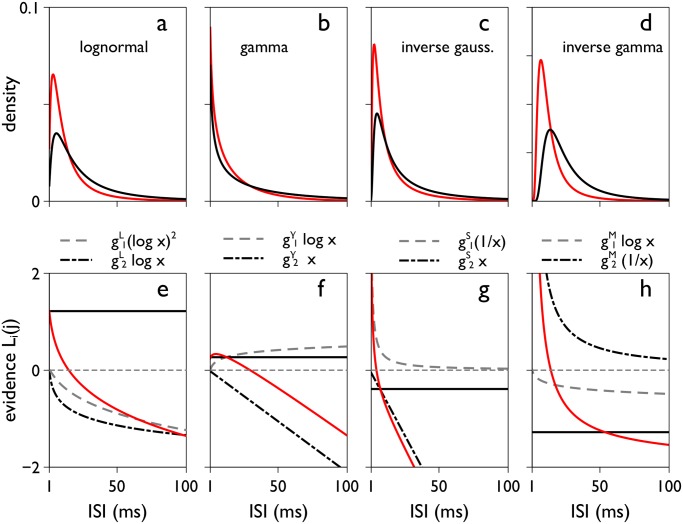
The two-parameter families of pdfs (top) and their ‘evidence contributions’ L
i(j) (bottom).Panels a-d show the lognormal, gamma, inverse Gaussian, and inverse gamma pdfs respectively, for the independent variance parameter set ΩIV (see Methods). The ‘preferred’ and ‘null’ density functions (f
*, f
0) are in red and black respectively. The plots are for ISIs from 1 to 100 ms. For infinitesimal ISIs, the lognormal, inverse Gaussian and inverse gamma tend to zero; for the the gamma the pdf grows up to a bound as the ISI tends to zero. Panels e-f are the corresponding contributions L
i(j) to the accumulated ‘evidence’ y
i(T) (see Eq 9) and the separate components therein (see Table 1). L
i(j) itself is shown in red, the constant term g0D (D = L, γ, S, M) by the solid black line, and non-constant terms by dashed-grey and broken-black lines. The horizontal dashed grey line indicates 0 on the y-axis.